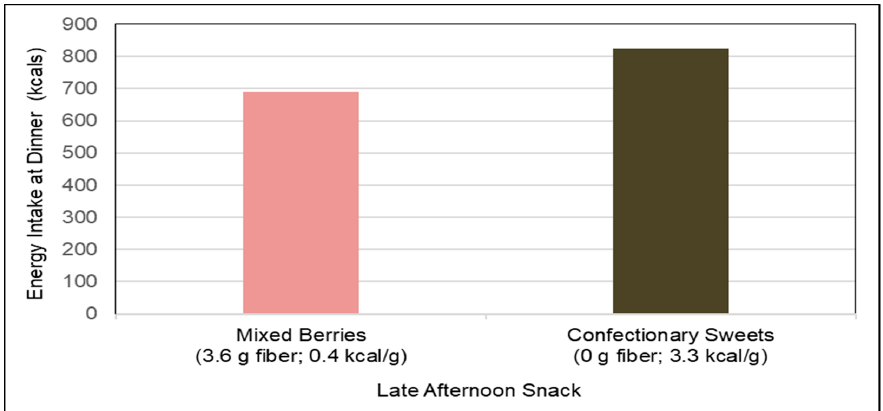
Figure 7. Mean energy intake at ad-libitum dinner after a late afternoon 65 kcal pre-dinner snack of mixed berries vs. confectionary sweets ( p < 0.001)